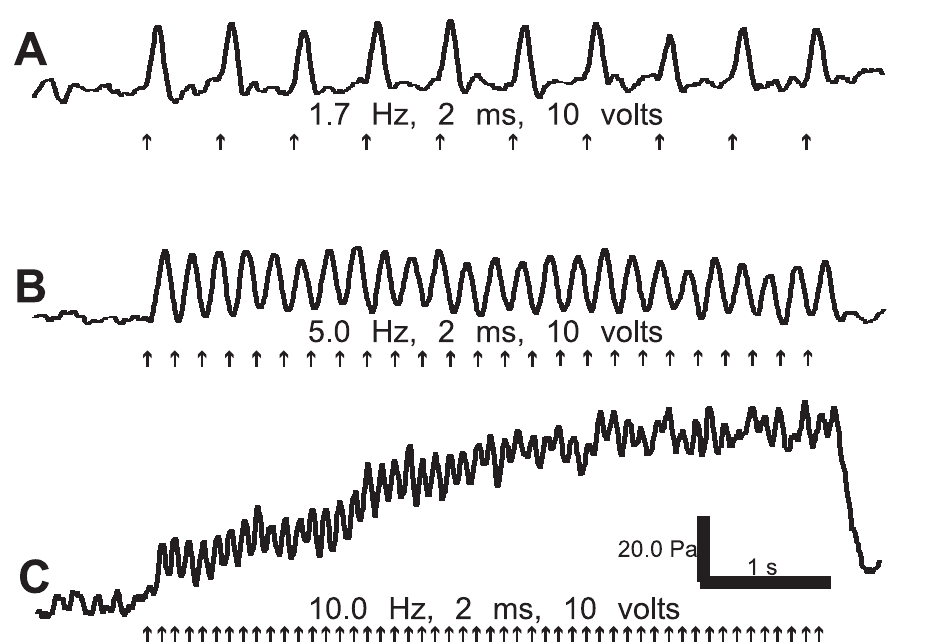
Fig 4. Contractile activity of the in vivo aorta following different frequencies of electrical stimulation. Stimulation was applied for 2 ms duration, 10V intensity over a 5s pulse train. (A-C) Representative recordings of phasic contractions in response to 1.7 Hz (A), 5 Hz (B) and 10 Hz (C) stimulation frequencies. [Note: the fast contractions superimposed on a tonic rise in pressure in C.]